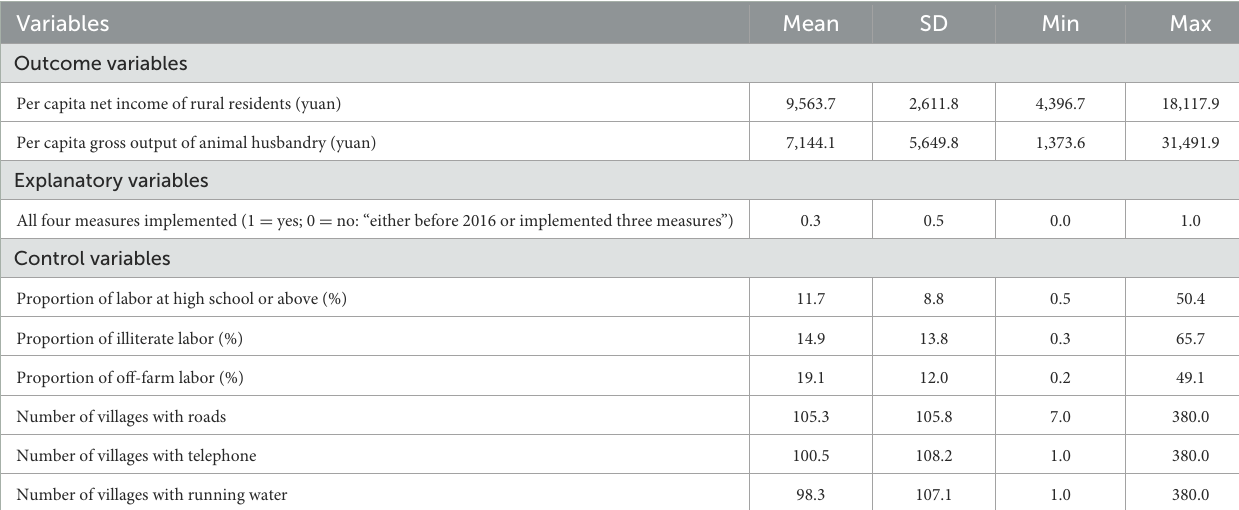
TABLE 4 Descriptive statistics of variables used in the analysis, all county-by-year observations ( N =